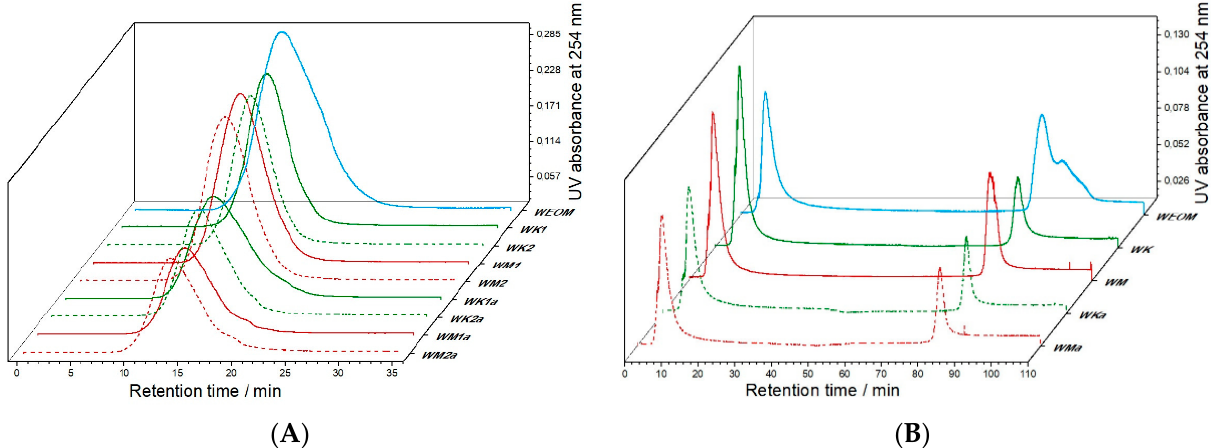
Figure 3. HPSEC chromatograms of WEOM ( A ) and amphiphilicity ( B ) before and after adsorption on kaolinite and mus- covite. Table 3. WEOM properties before and after adsorption on minerals and the amount of C org adsorbed. Sample